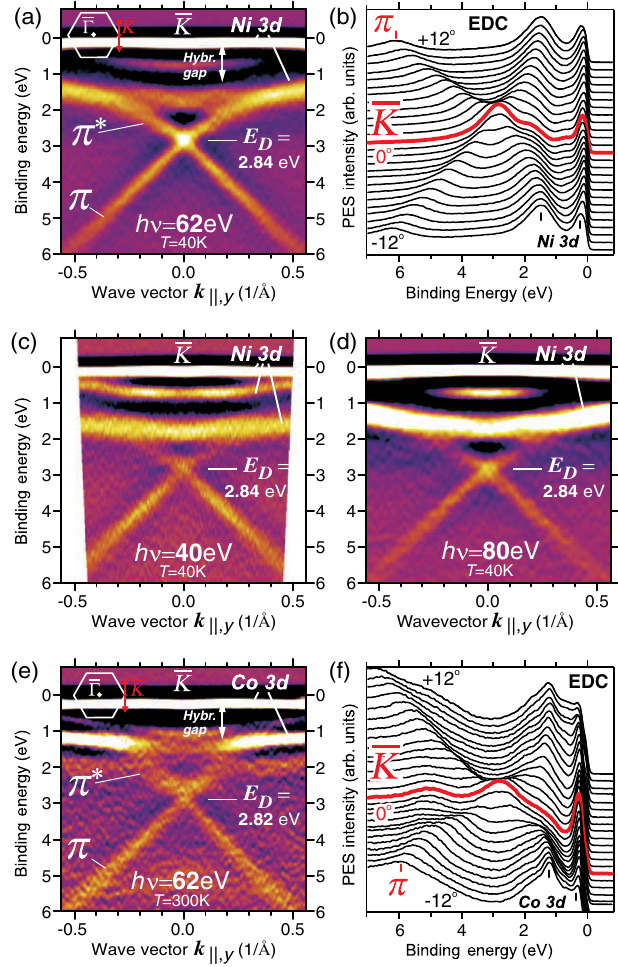
FIG. 4. Direct observation of intact Dirac cones measured perpendicular to the (cid:5) K direction. (a),(b) Dirac cone in graphene on Ni(111) measured at h(cid:2) ¼ 62 eV (color plot and EDCs). (c), (d) Dirac cone in graphene on Ni(111) sampled at h(cid:2) ¼ 40 and 80 eV. (e),(f) Intact Dirac cone measured in graphene on Co(0001) at h(cid:2) ¼ 62 eV (color plot and